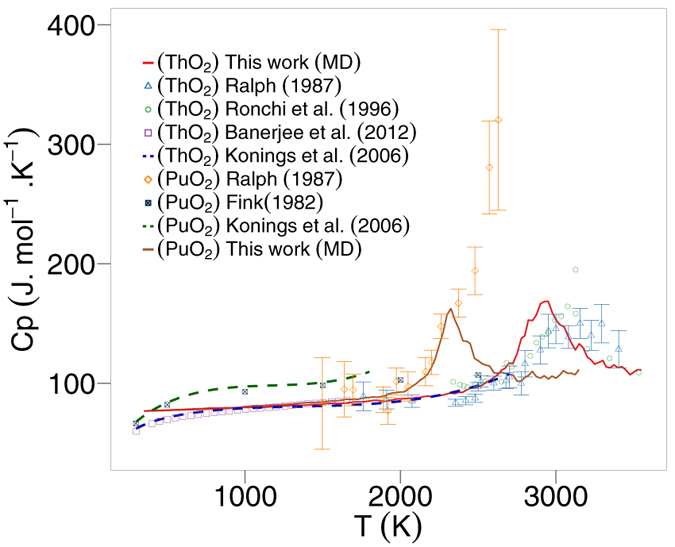
Variation of specific heat capacity against temperature for PuO2 and ThO2, where the solid lines represent MD results and the points represent experimental data20212324.